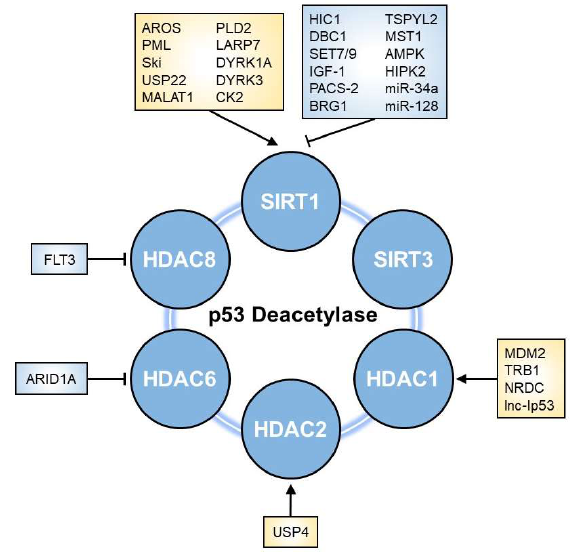
Figure 3. Regulators of p53 deacetylase. The deacetylation activity towards p53 is influenced by multiple factors, including E3 ubiquitin ligases, kinases, miRNAs, and other proteins. Arrows and perpendicular bars indicate enhancing and suppressive effects towards p53 deacetylases, respec- tively.